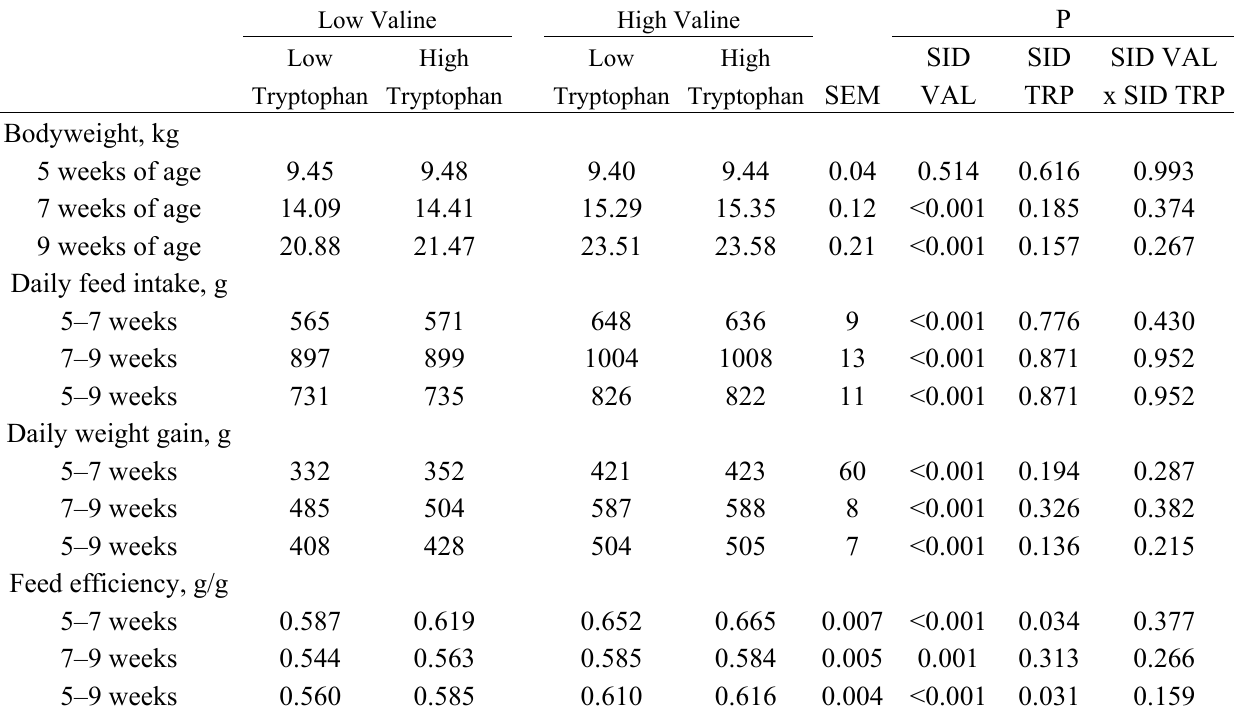
Table 3. Influence of valine and tryptophan concentration on performances of the piglets 1,2 . Low Valine High